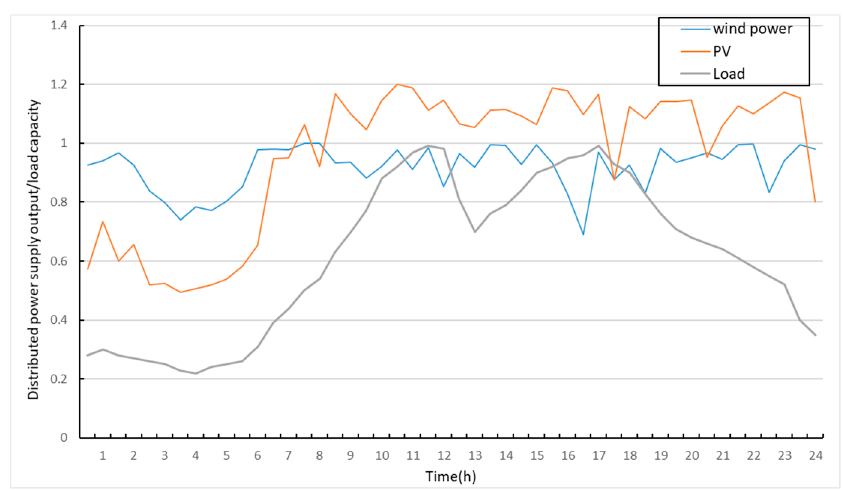
Figure 10. Optimal output of DG in network 2 with static var compensator (SVC).